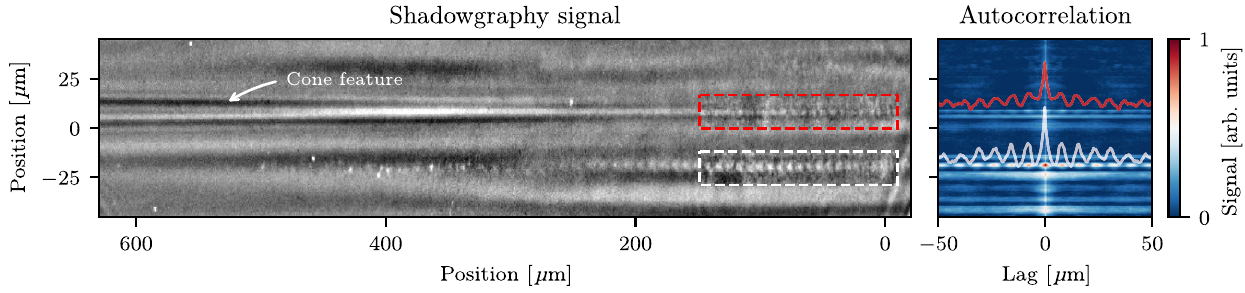
FIG. 2. Shadowgram of laser- and beam-driven plasma waves in the second gas jet. Left : Laser- and beam-driven plasma waves in the second gas jet (propagating to the right) after a free drift and spatial separation. Note the conelike feature trailing only the upper plasma wave. Right : Autocorrelation of each row of the signal in the interval of the marked plasma waves on the left. The red and white lineouts show the respective periodic signal modulations caused by the plasma